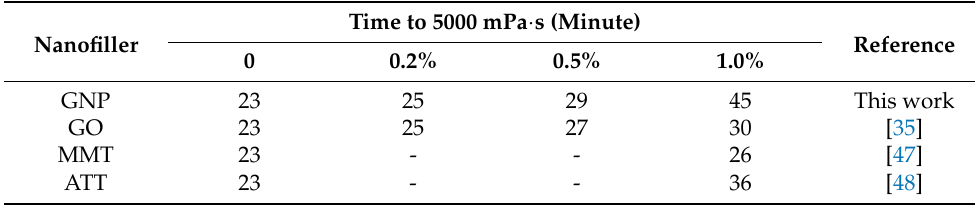
Table 4. Time to 5000 mPa · s of GNP-reinforced EABCs at 120 ◦ C.